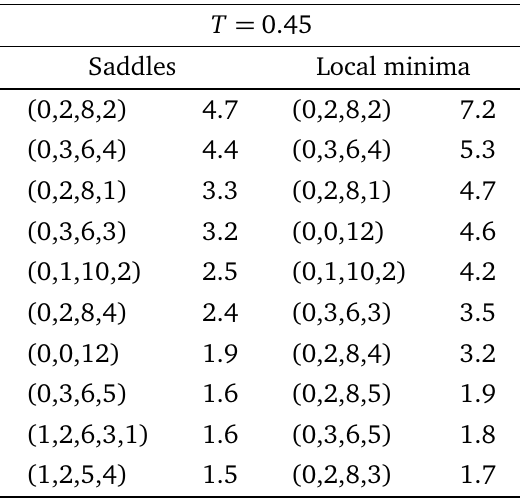
Table 3: Percentage of most frequent Voronoi signatures in saddles and local minima sampled at T =